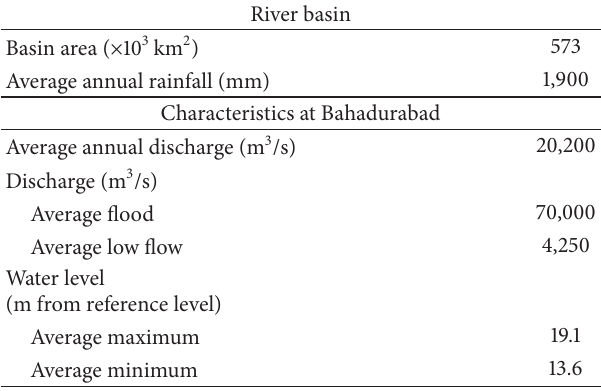
Table 1: Key hydrological characteristics of the